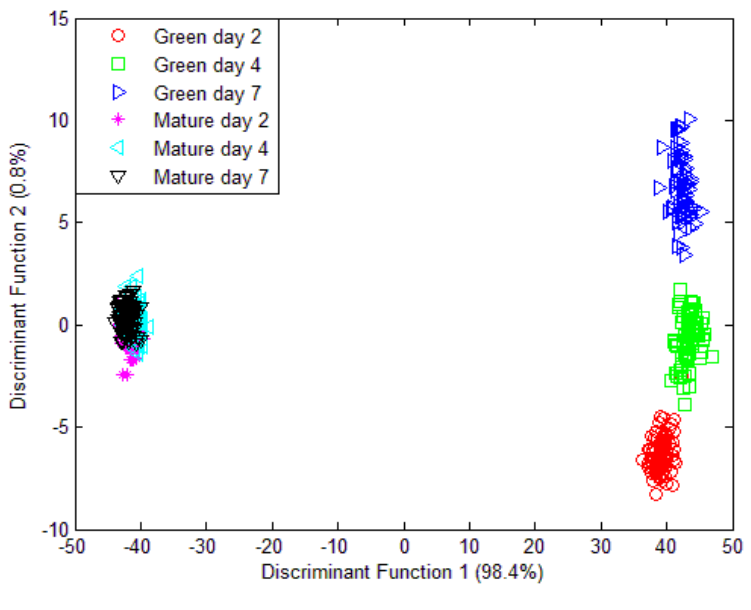
Figure 11. LDA plot of 32 e-nose sensors responses for three different maturity and ripeness level of Harumanis harvest at two different date (week 7 and week